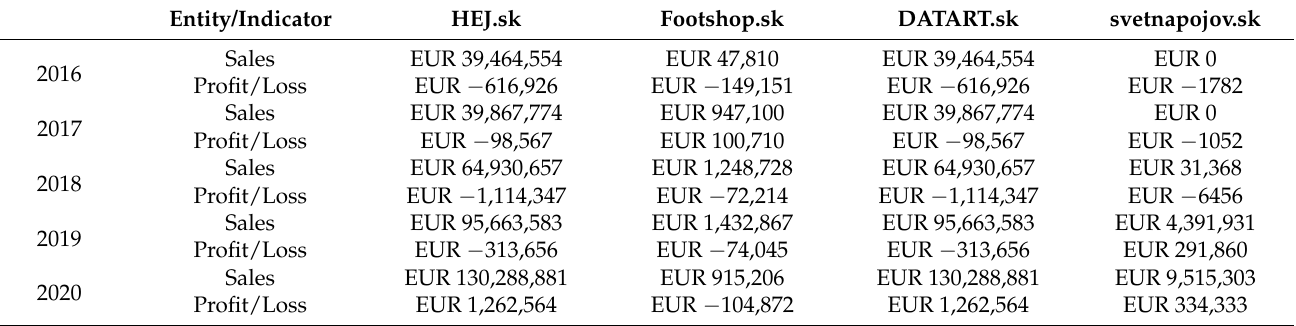
Table 4. Sales and profit development (Finstat 2022).